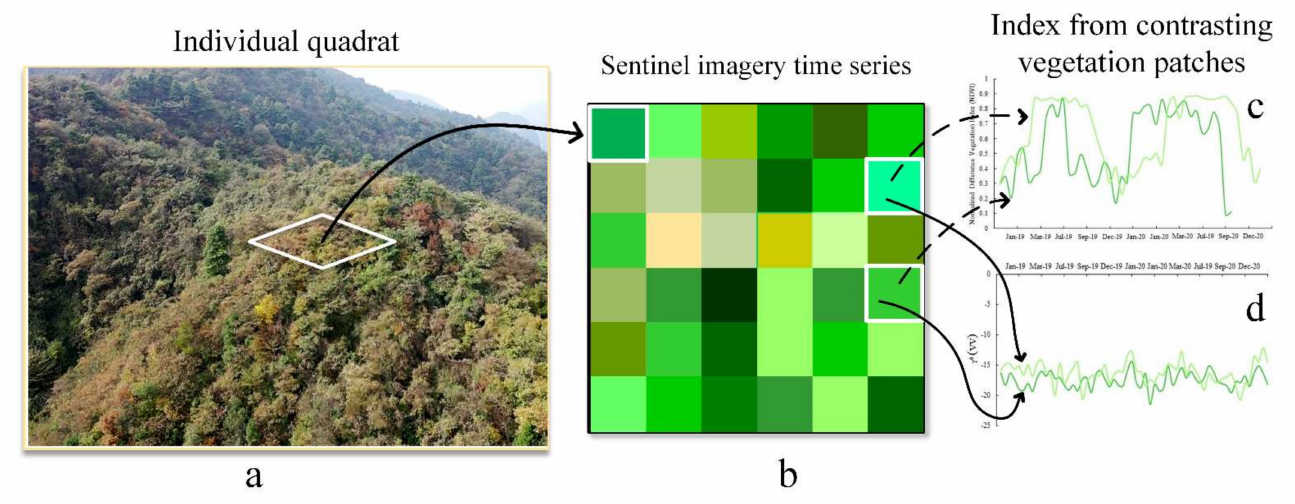
Figure 3. Field quadrat: ( a ) aerial photo; experimental images of individual-level quadrats are from northwestern Hubei, China. ( b ) Sentinel imagery time series layout; one quadrat of 100 m 2 (10 m × 10 m) corresponds to one theoretical pixel in an image. ( c ) Reconstructed Sentinel-2 NDVI and ( d ) Sentinel-1 vertical/vertical (VV) polarization with a one-month step for different